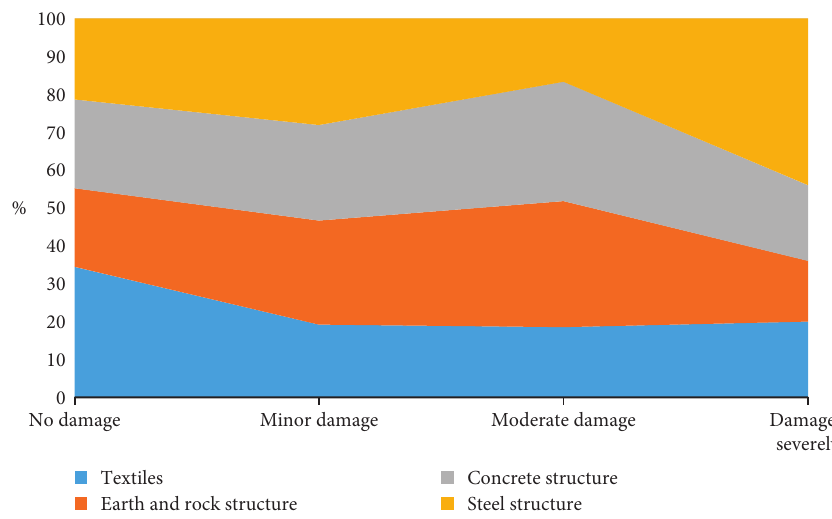
Figure 8: Different degree of material damage.